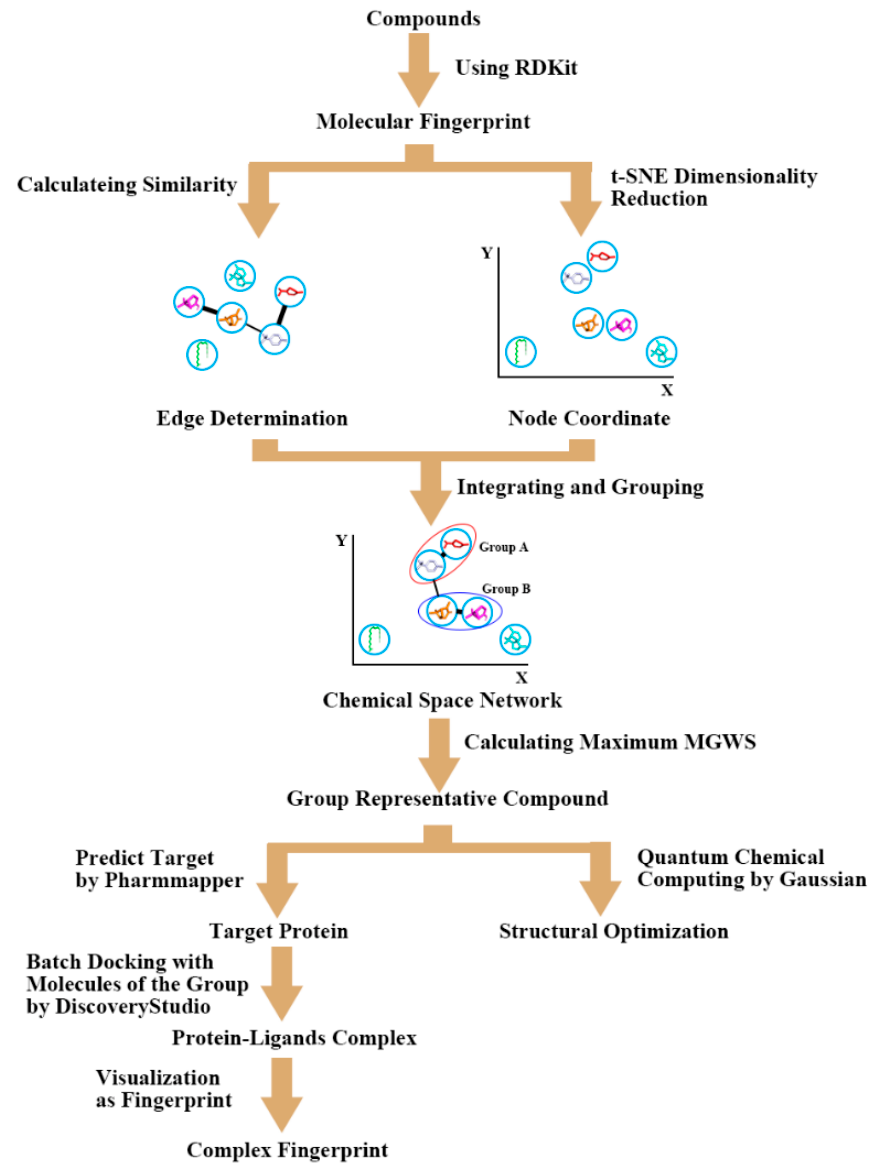
Figure 8. The workflow of the study methods.